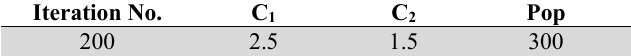
Parameter values of MOPSO Pareto front Iteration No.